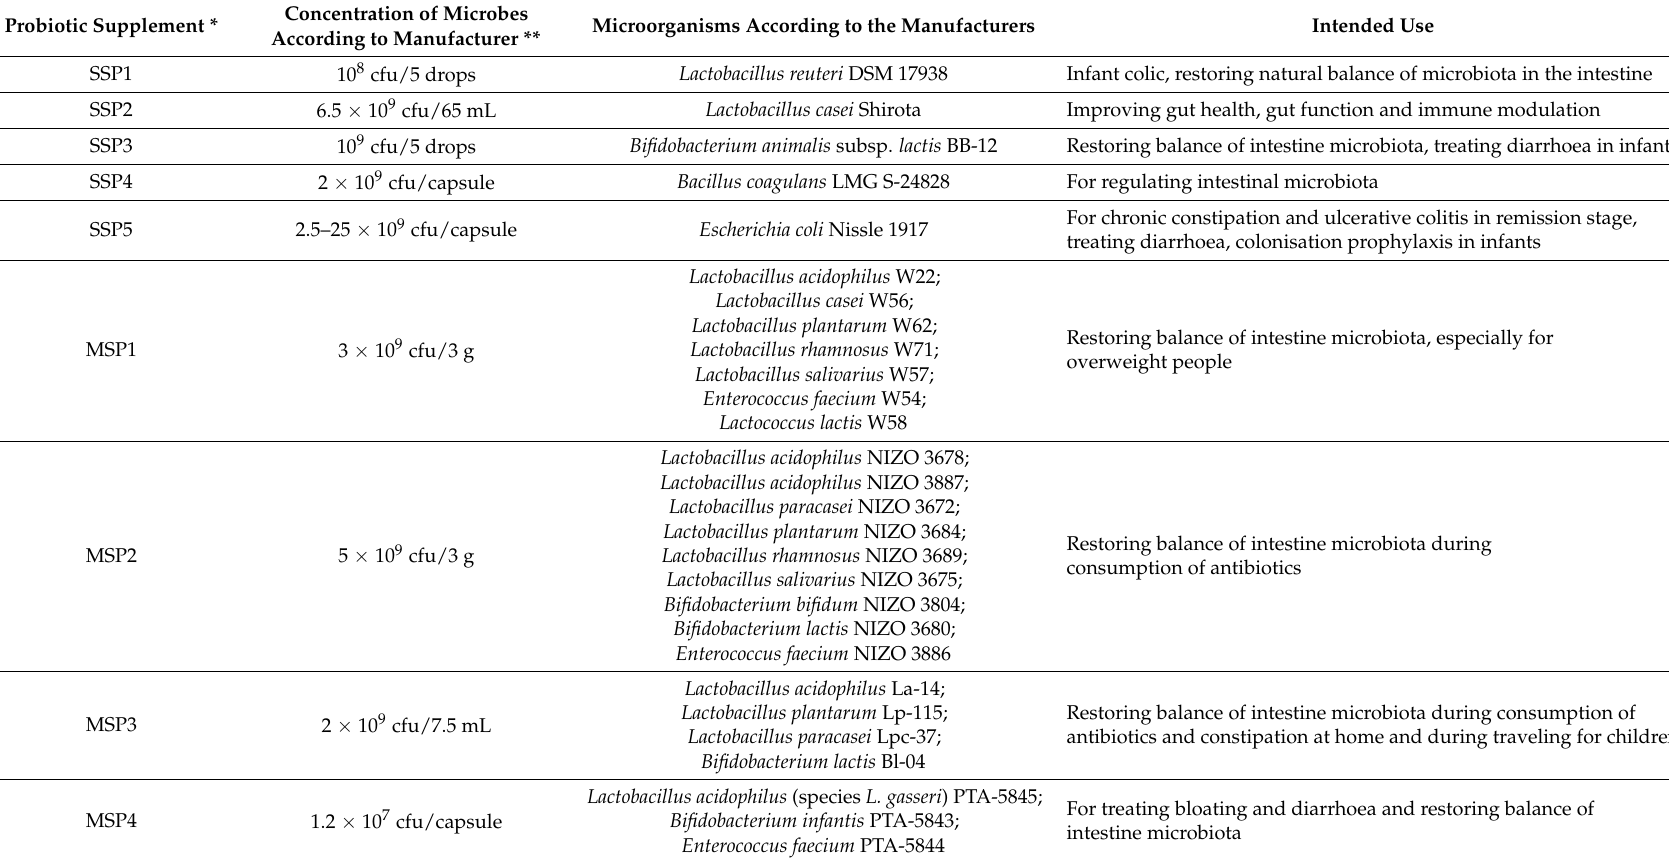
Table 1. Characteristics of the probiotic